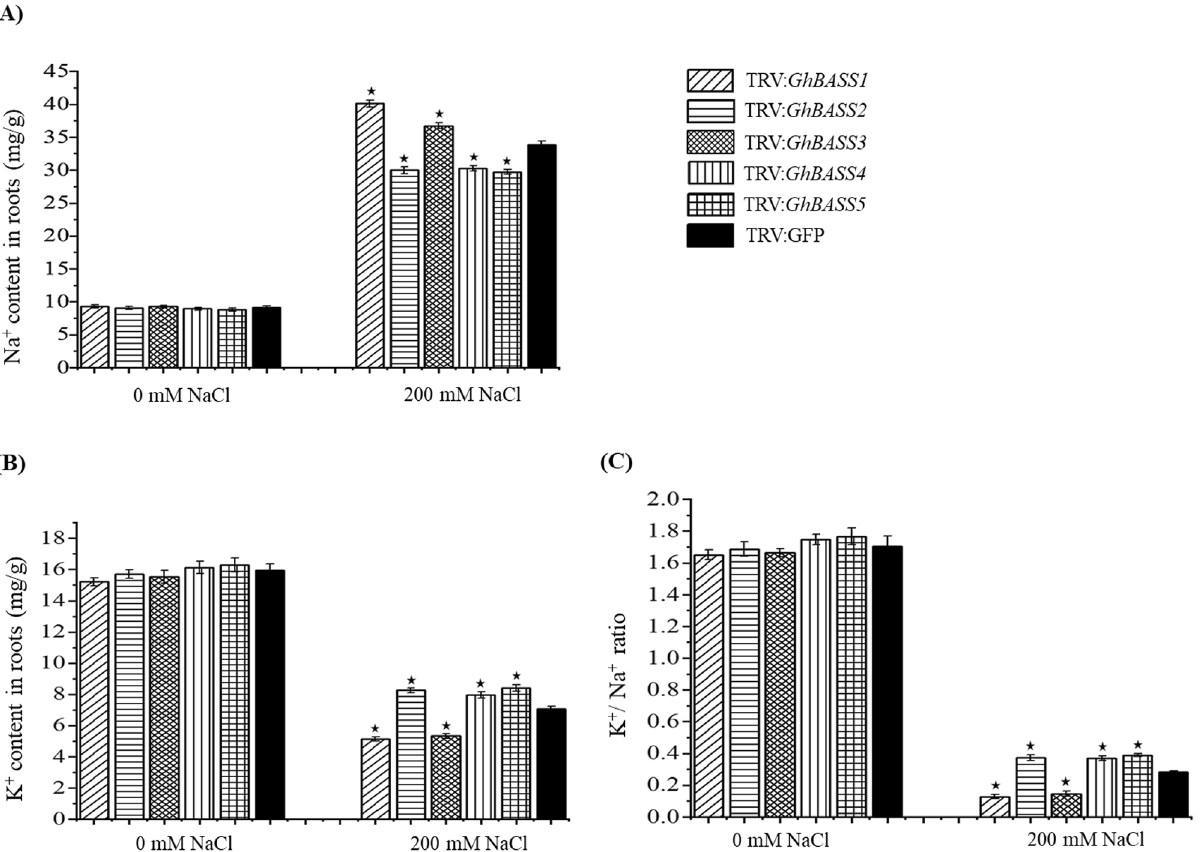
Figure 10. Ion contents in GhBASSs knock-down roots with the absence or presence of 200 mM NaCl for 5 days. ( A ) Na + content in the roots of gene silencing plants. ( B ) K + content in the roots of gene silencing plants. ( C ) K + /Na + ratio. The ionic concentration is presented as mg/g dry weight. Means and standard deviations were based on three independent biological replicates. Error bars represent the variation among three independent biological replications. Asterisks indicate the significant difference ( * , P = 0.05) from TRV:GFP by Tukey’s HSD